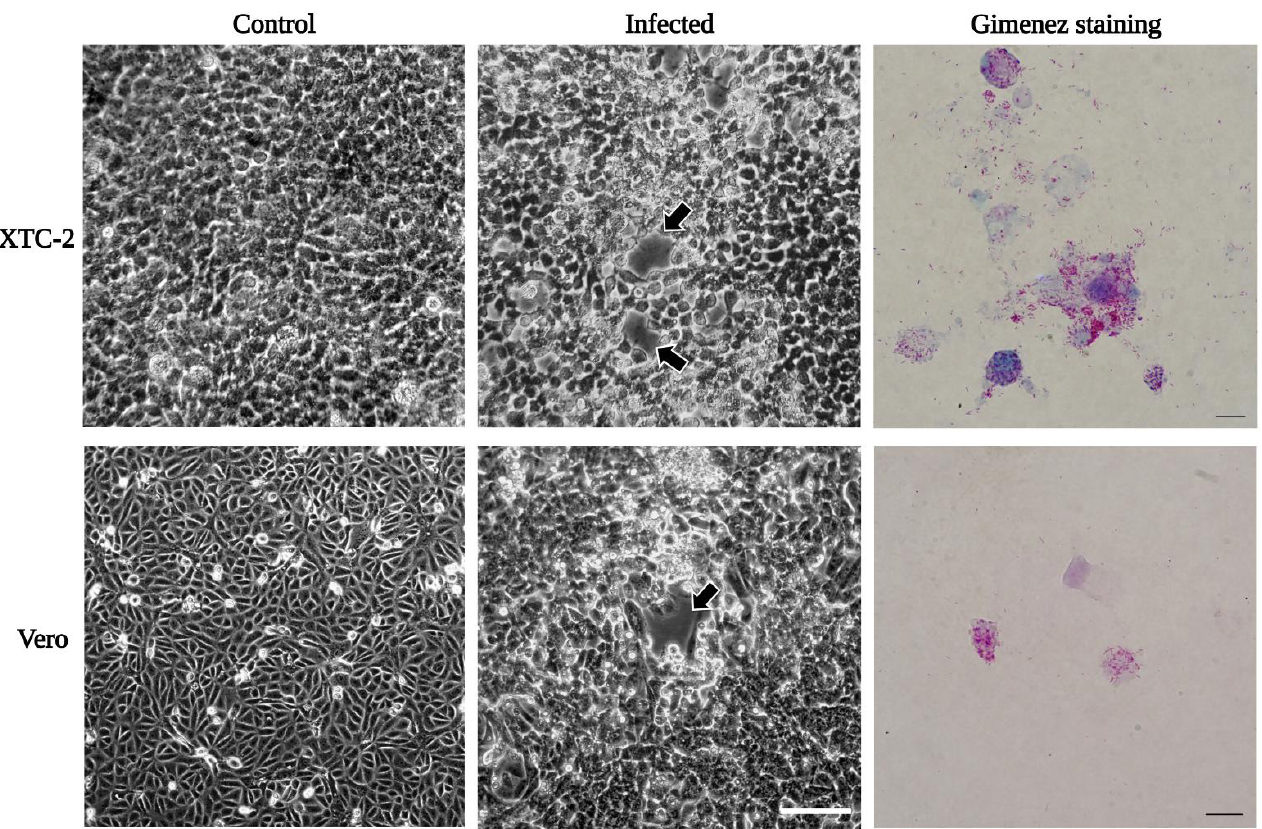
Figure 3. Growth of R. felis Danube in XTC-2 and Vero cells. Rickettsiae were propagated in XTC-2 and Vero cells at 28 °C and 32 °C, respectively. We observed an apparent cytopathic effect (plaque formation, black arrows) in the infected host cells at 6 dpi in XTC-2 and 14 dpi in Vero cells (Zeiss Axiovert 40 CFL trinocular inverted phase-contrast microscope; scale bar: 100 µm). Rickettsia felis stained magenta in contrast to host cells in blue by Gimenez technique (Leica DM 4500B microscope; scale bar 10 µm).